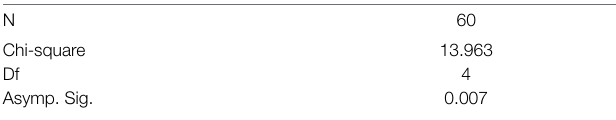
TABLE 5 | Friedman test statistics of the pedagogy-related emotional scaffolding strategies in the teachers’ views.